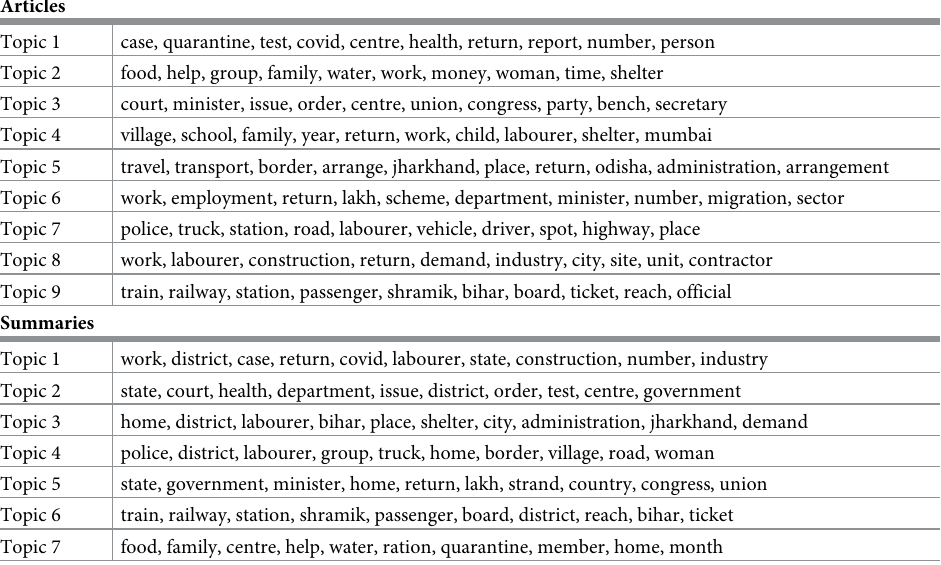
Table 1. Illustrating the words describing various topics identified using BoW model for both article text and summaries.